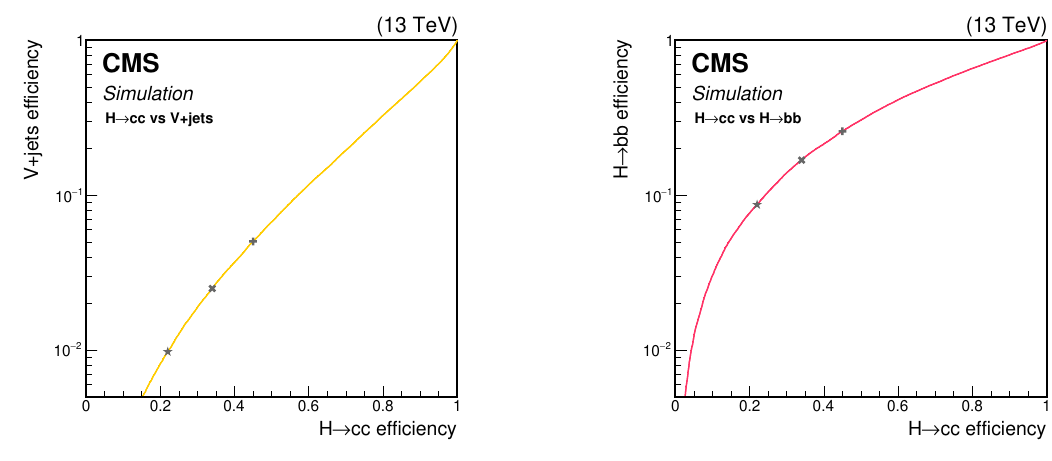
Figure 3 . The performance of the cc discriminant to identify a cc pair in terms of receiver operating characteristic curves, for large- R jets with p > 200 GeV, before the application of data- T to-simulation scale factors. Left: the e(cid:14)ciency to correctly identify a pair of c quarks from H boson decay vs. the e(cid:14)ciency of misidentifying quarks from the V+jets process. Right: the e(cid:14)ciency to correctly identify a pair of c quarks from H boson decay vs. the e(cid:14)ciency of misidentifying a pair of b quarks from H boson decay. The gray stars and crosses on the ROC curves represent the three working points used in the merged-jet topology